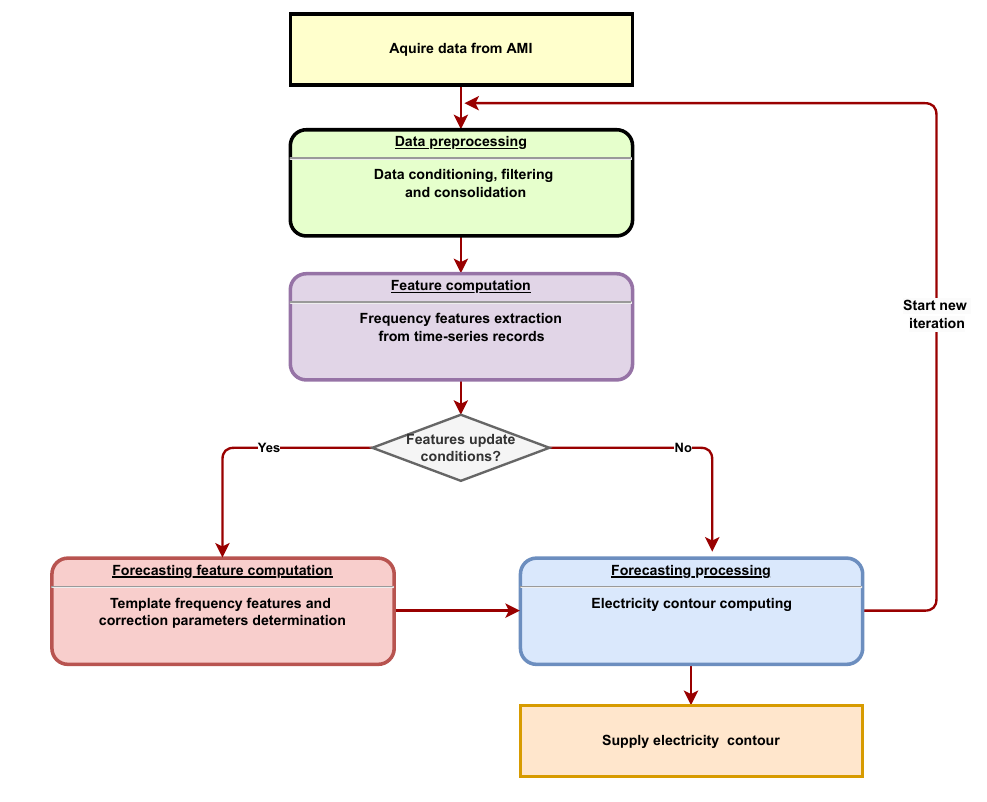
Figure 2. Conceptual framework of the electricity contour